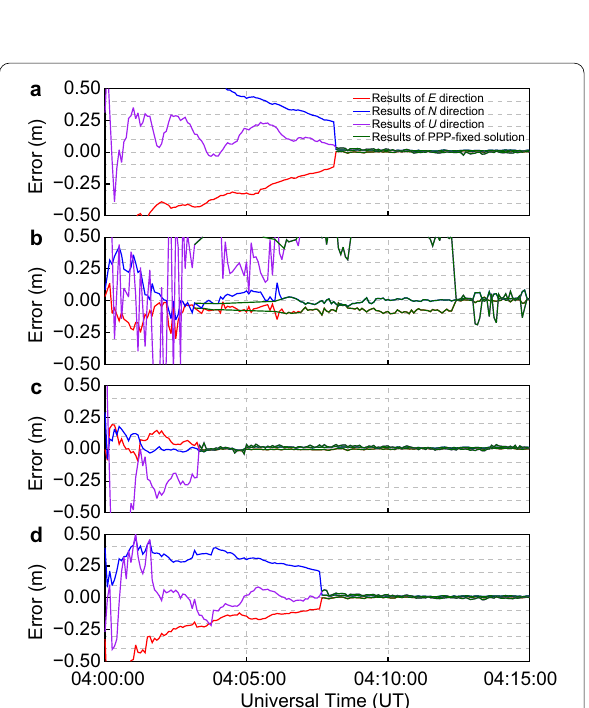
Fig. 8 The convergence time of a PPP-AR, and the ionospheric delay corrections with an error of 3 TECU while b the variance is very small (< 1 TECU), c the variance is the optimum ( variance is large (>